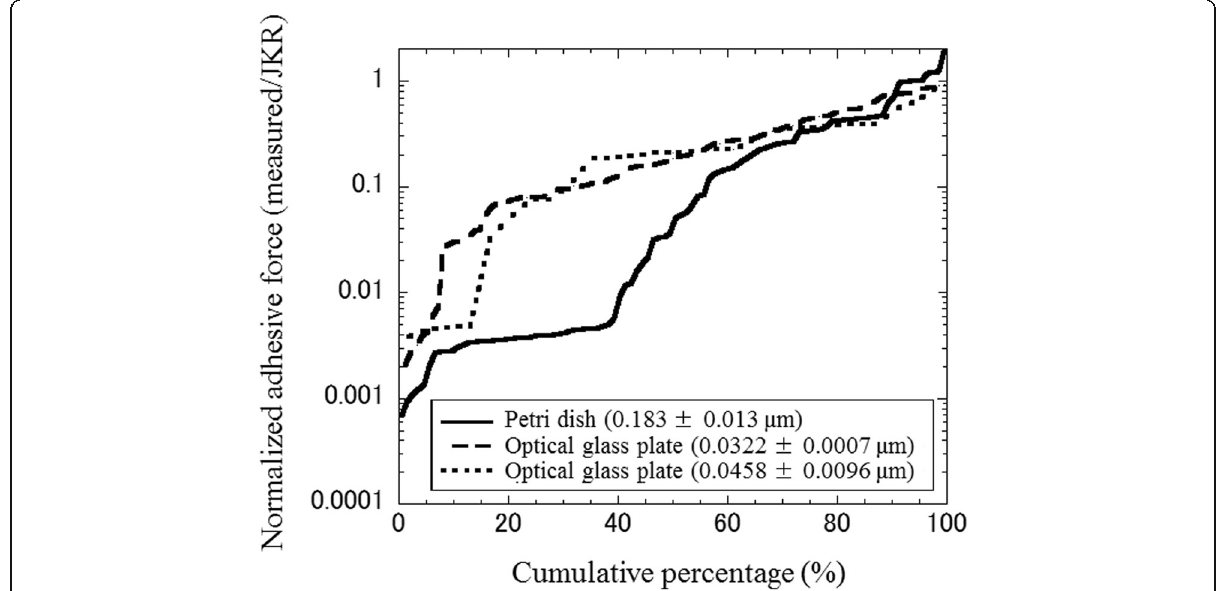
Fig. 7 Effect of surface roughness. The ratios of the measurement values of the adhesive force of the 100 μ m glass beads obtained using a Petri dish and two optical glass plates having different surface roughnesses to the theoretical values plotted against the cumulative percentage. Solid line, dashed, and dotted lines correspond to the results of the Petri dish, smoother optical glass plate, and another optical glass plate, respectively. The numbers in parentheses show the roughness ( R a